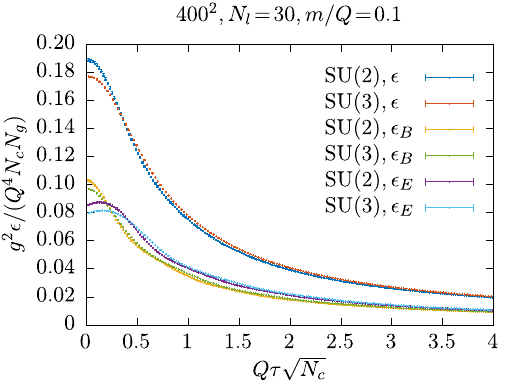
Fig. 1 Total energy density and its chromo-magnetic and chromo- electric components for SU(2) and SU(3)